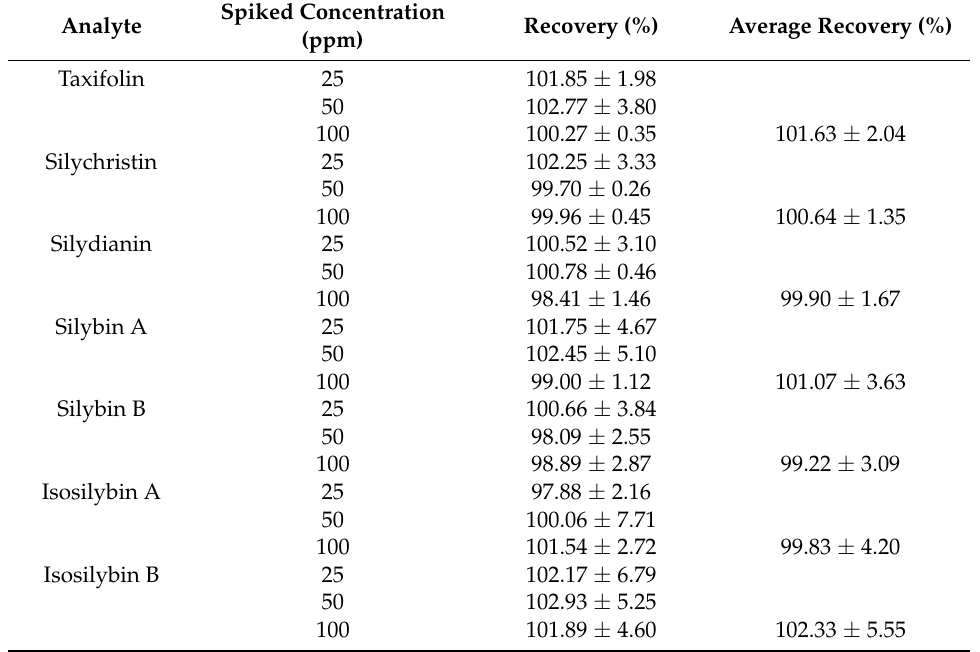
Table 3. Recovery results for individual analytes at three spiked concentrations in negative control (extraction solvent).